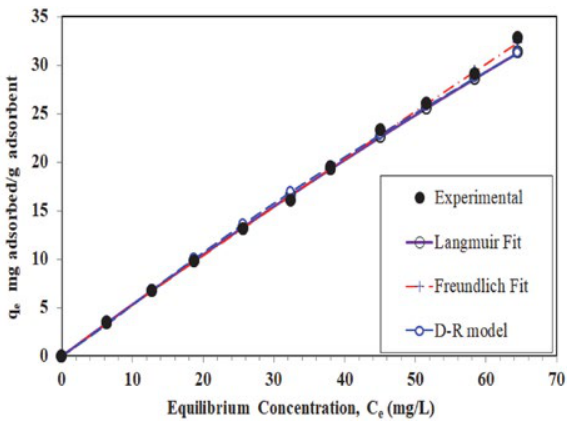
Figure 7. Comparison of experimental data with predictions of iso- therm models.